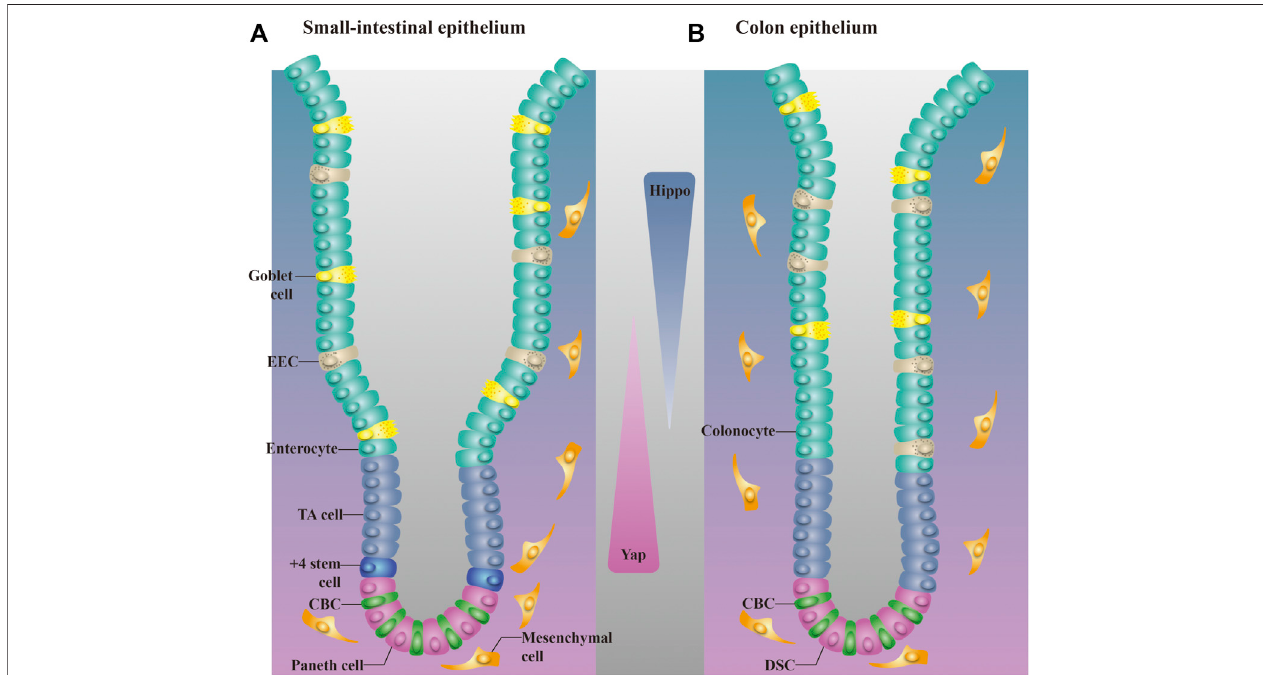
FIGURE 2 | Distribution of different cells in the small intestinal epithelium and colon epithelium. (A) . The small intestinal epithelium is organized into crypts and villi. CBC cells are present among Paneth cells, and +4 cells are restricted to the +4 position above the Paneth cell. TA cells are located above +4 cells. (B) . The colon epithelium lacks villi. Most cell types in the colon epithelium are also found in the small intestine. DSCs are equivalent to Paneth cells in the colon and are intercalated between CBC cells. EEC, enteroendocrine cell. Activation of the Hippo pathway follows an ascending gradient along the crypt – villus axis, whereas YAP activity shows a descending